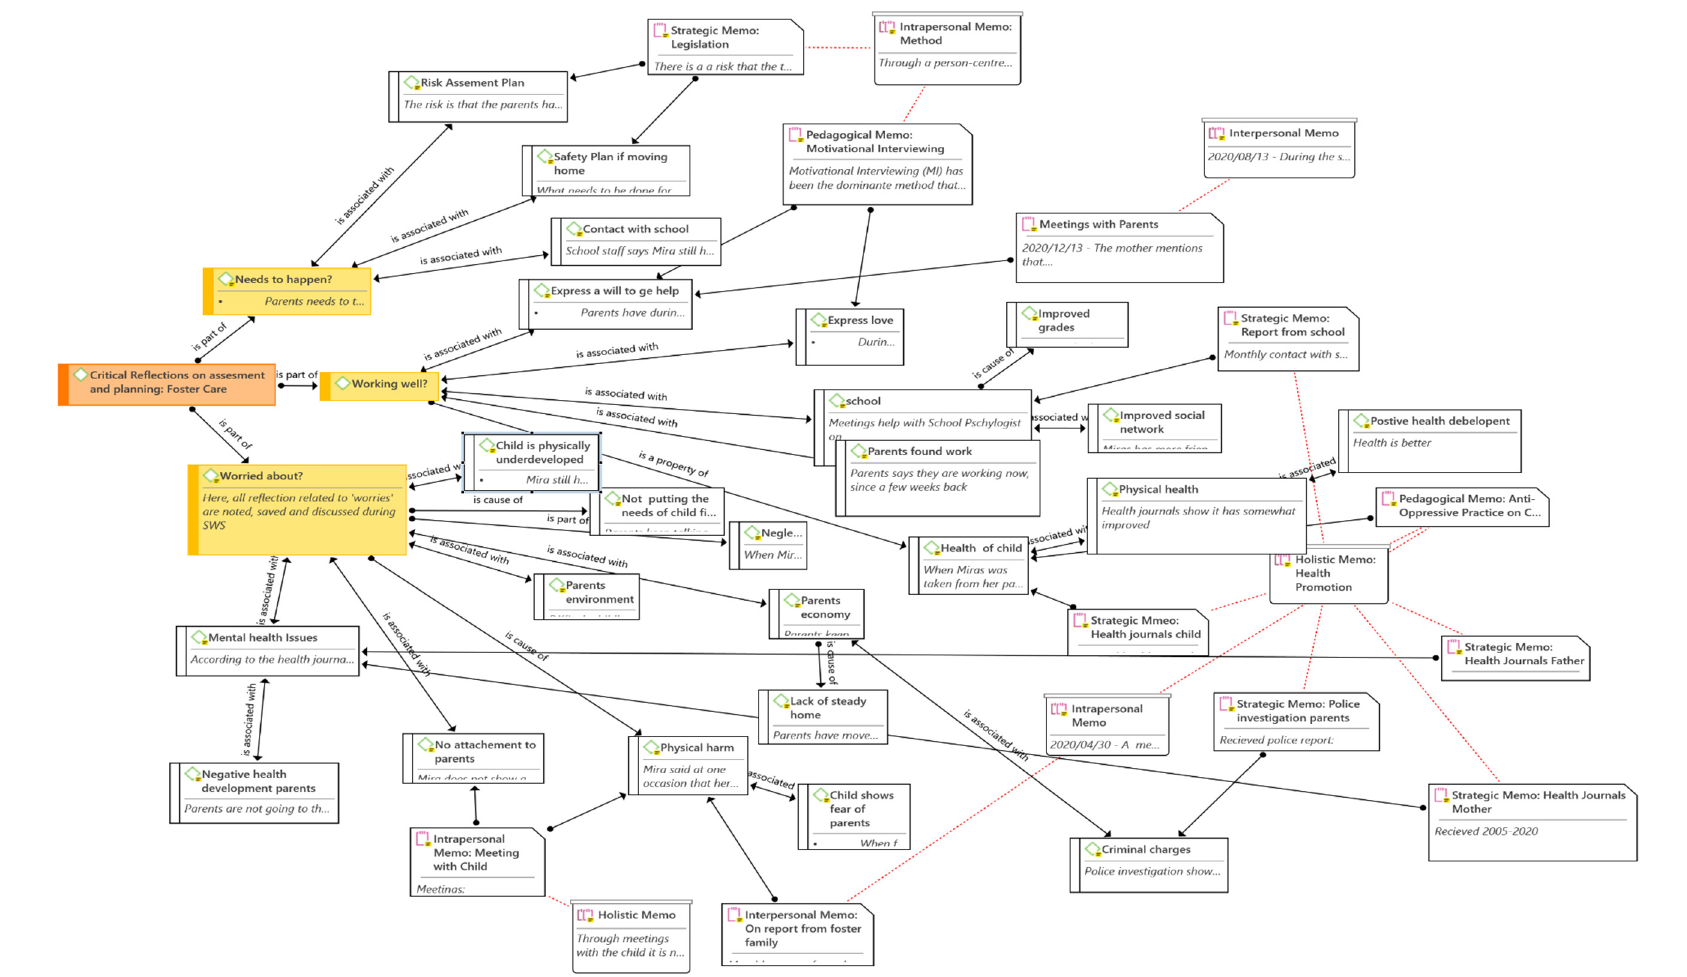
Figure 4. Example of a network on critical reflection with codes, notes, memos, and links.